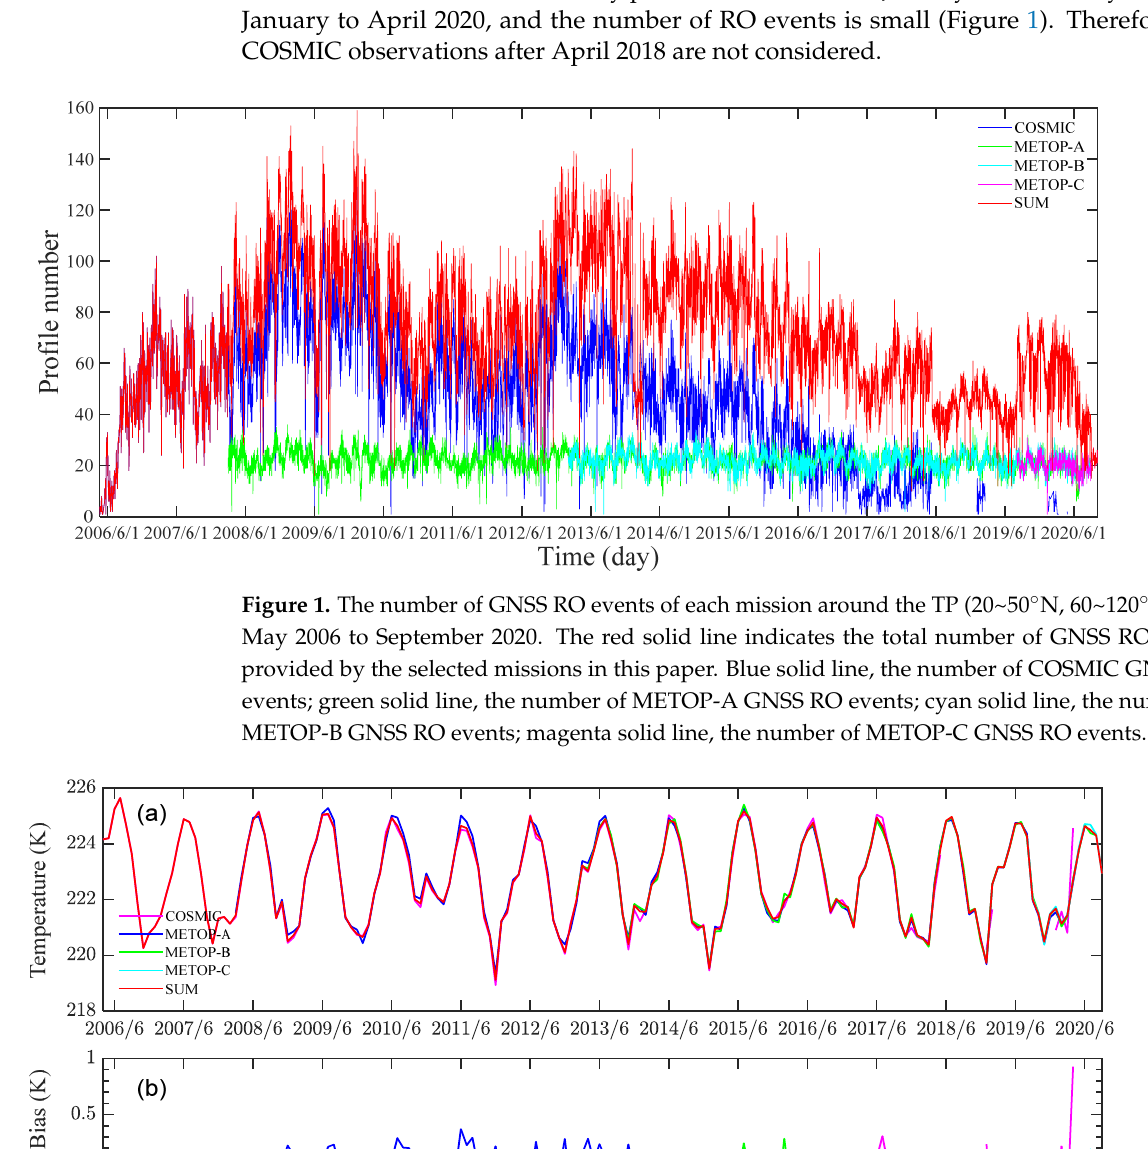
Figure 1. The number of GNSS RO events of each mission around the TP (20~50°N, 60~120°E) from May 2006 to September 2020. The red solid line indicates the total number of GNSS RO events pro ‐ vided by the selected missions in this paper. Blue solid line, the number of COSMIC GNSS RO events; green solid line, the number of METOP ‐ A GNSS RO events; cyan solid line, the number of METOP ‐ B GNSS RO events; magenta solid line, the number of METOP ‐ C GNSS RO events.